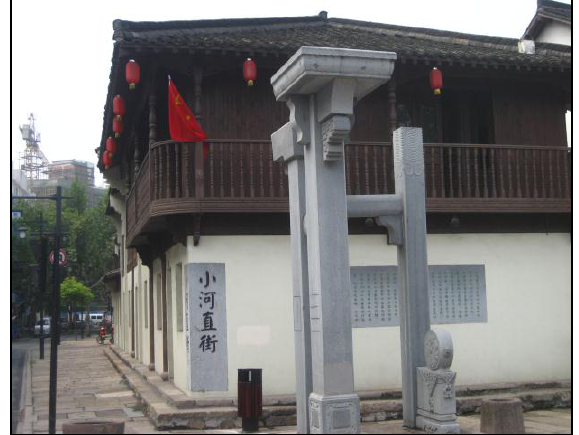
Figure 1 Entry logo of Xiao He Zhi Jie and the traditional timber construction upper floor